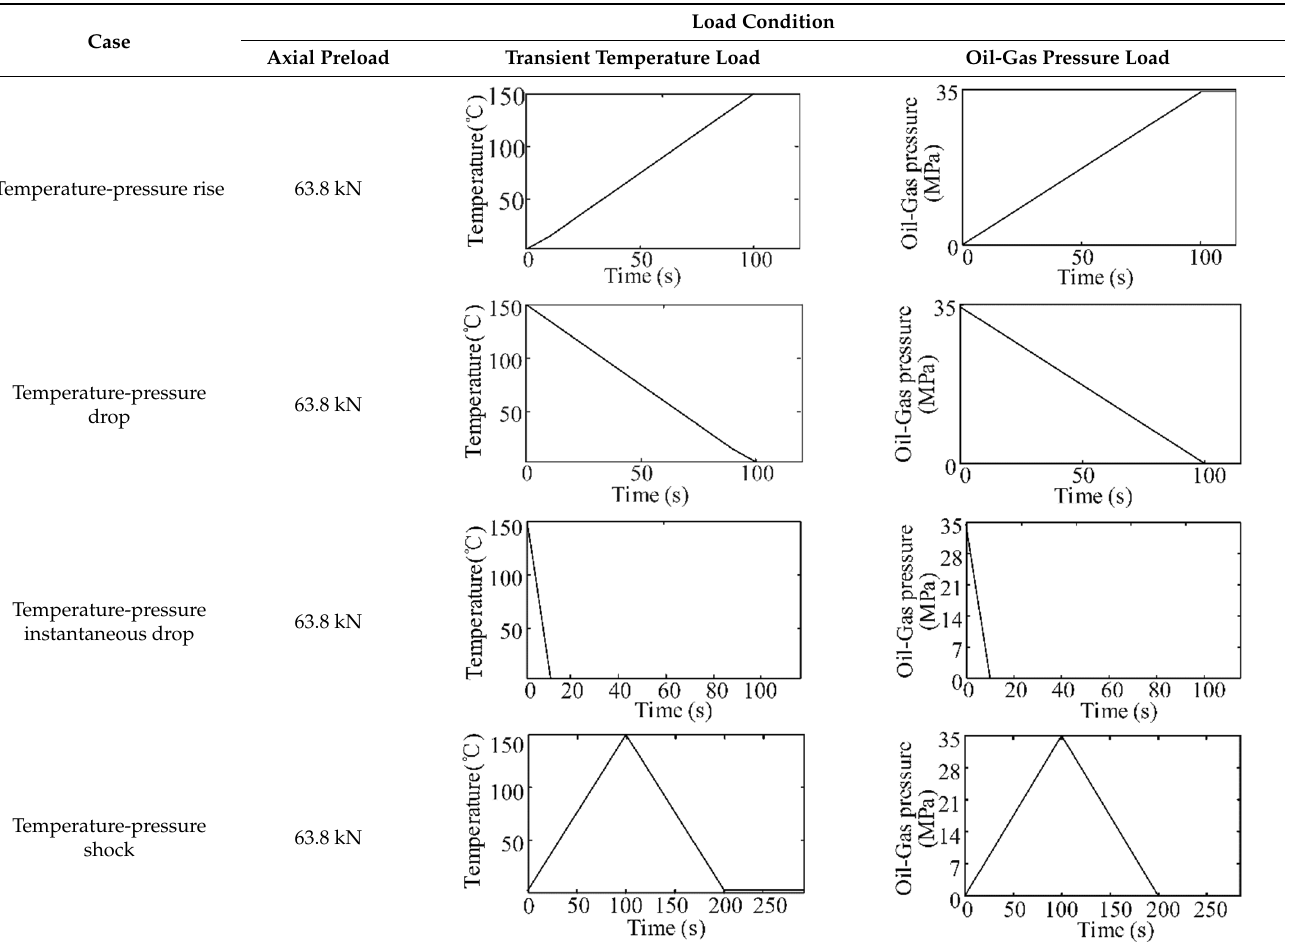
Table 6. Transient temperature field load conditions.